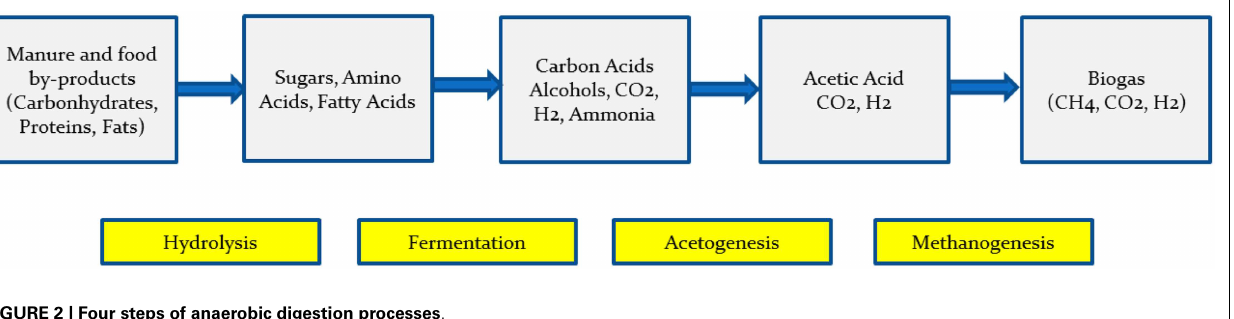
FIGURE 2 | Four steps of anaerobic digestion processes